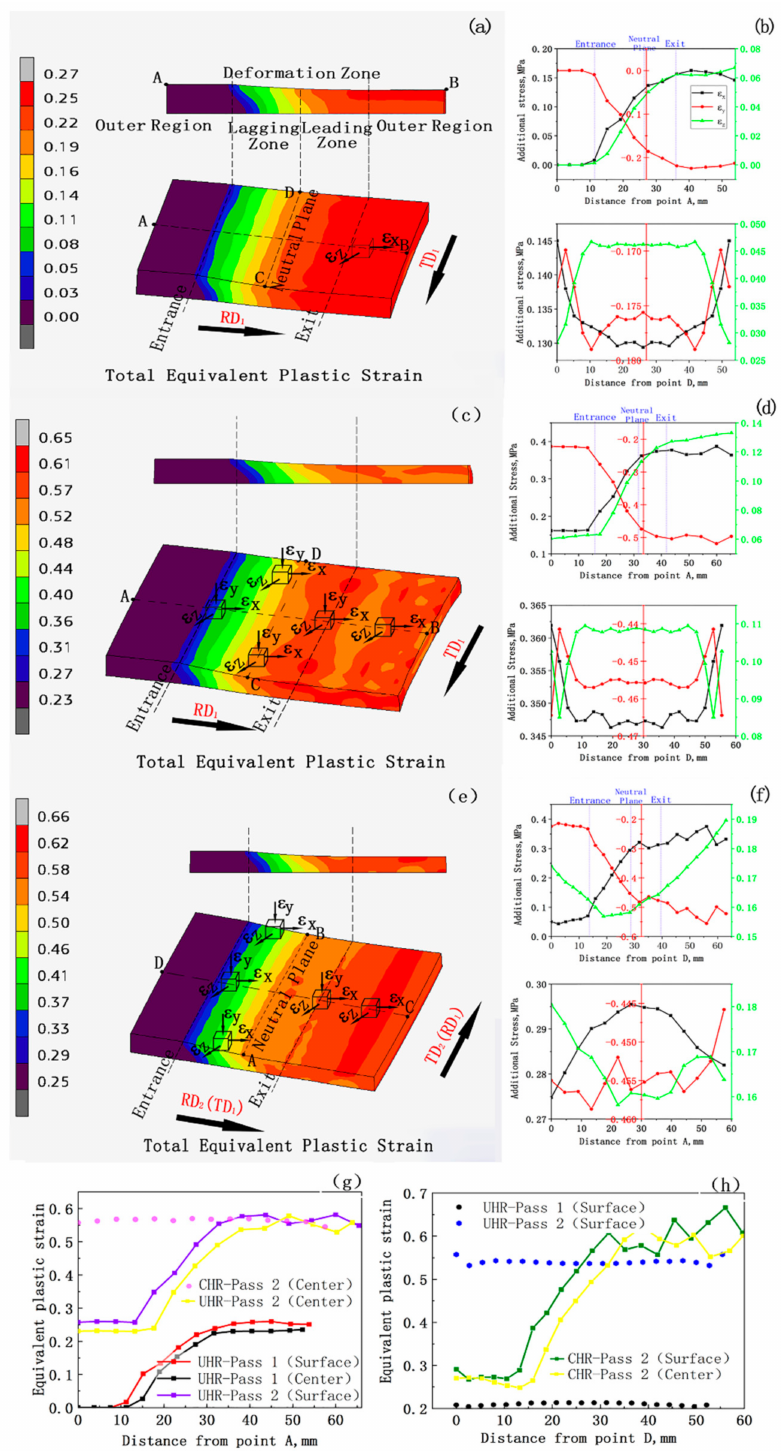
Figure 7. The contour maps of equivalent plastic strain in the rolling deformation zone: ( a ) the first pass and ( c ) the second pass in UHR; ( e ) the second pass in CHR; ( b , d , f ) distributions of additional strain along AB and DC lines in each pass; ( g , h ) evolution of equivalent strain along AB and DC lines,